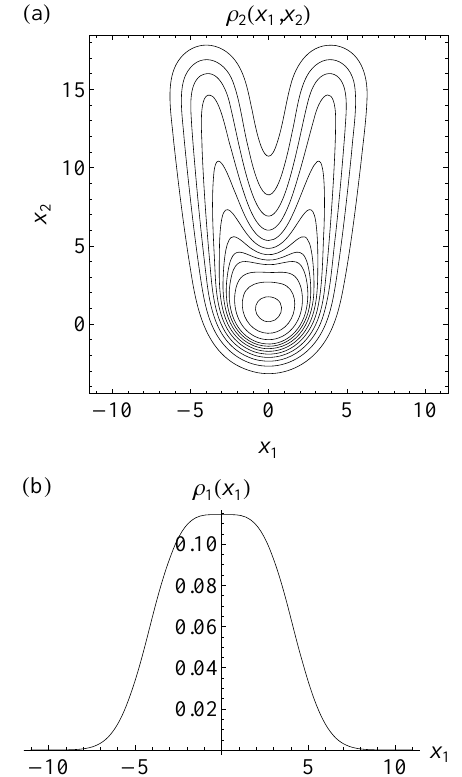
Fig. 2. The contours of a two dimensional marginal PDF ρ 2 (x 1 ,x 2 ) (a) . Integrating ρ 2 (x 1 ,x 2 ) in the x 2 direction gives the one dimen- sional marginal PDF ρ 1 (x 1 ) (b) . In this case the plots illustrate that the quantities ∂ρ 2 /∂x 1 and ∂ρ 1 /∂x 1 , which may be used in (8) are